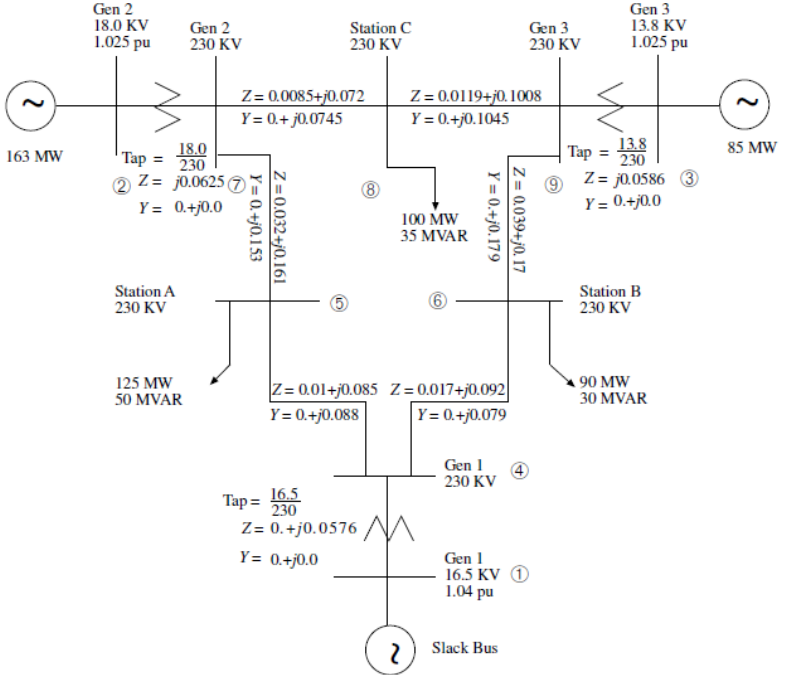
Figure 7. WECC three-machine, nine bus system, Reprinted from